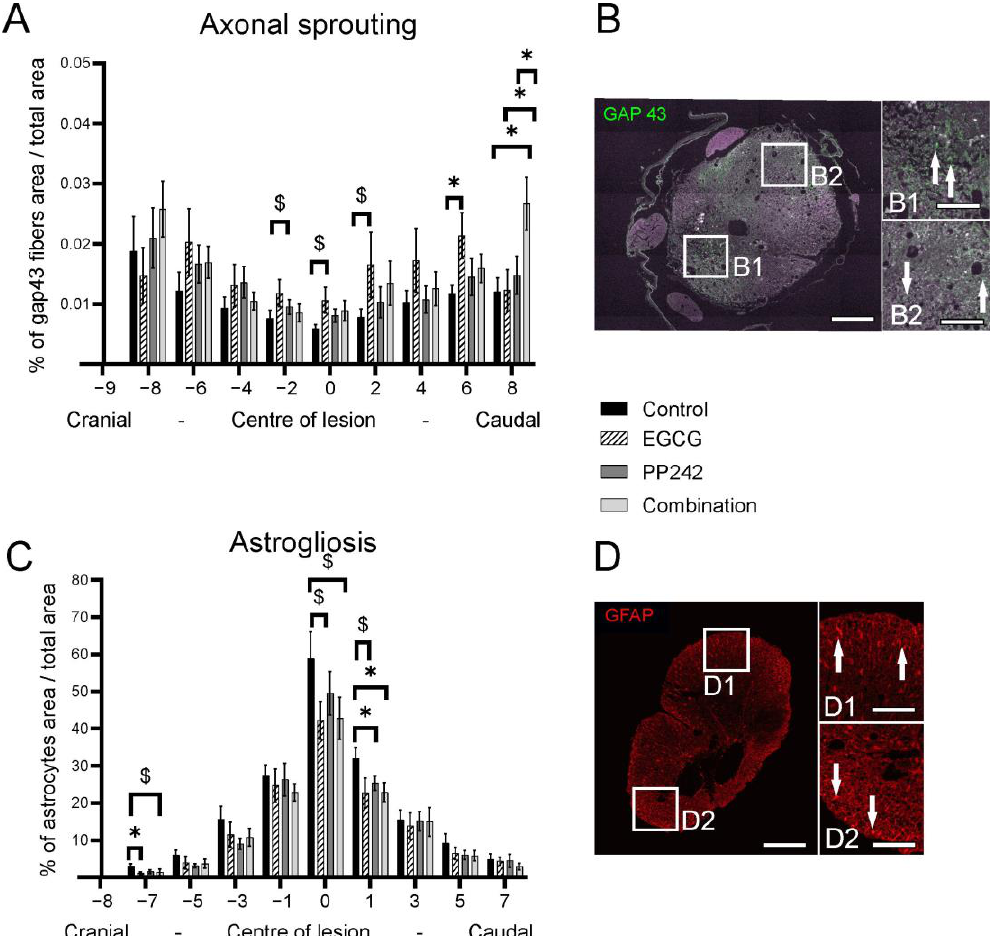
Figure 4. Histopathological and immunohistochemical investigation of the spinal cord . ( A , B ) The axonal sprouting, as detected by GAP-43 expression, was significantly higher 6 mm and 8 mm caudally to the lesion center in the EGCG-treated group and EGCG + PP242-treated group compared to controls . ( C , D ) In rats treated with EGCG, PP242, and EGCG + PP242, the GFAP-positive area was significantly reduced compared to the control, especially at the lesion site and in the immediate caudal region (* p < 0.05), ($ p 0.05 –0.1) Scale bar 500 μm ( B , D ), 100 μm (B1, B2, D1, D2) .